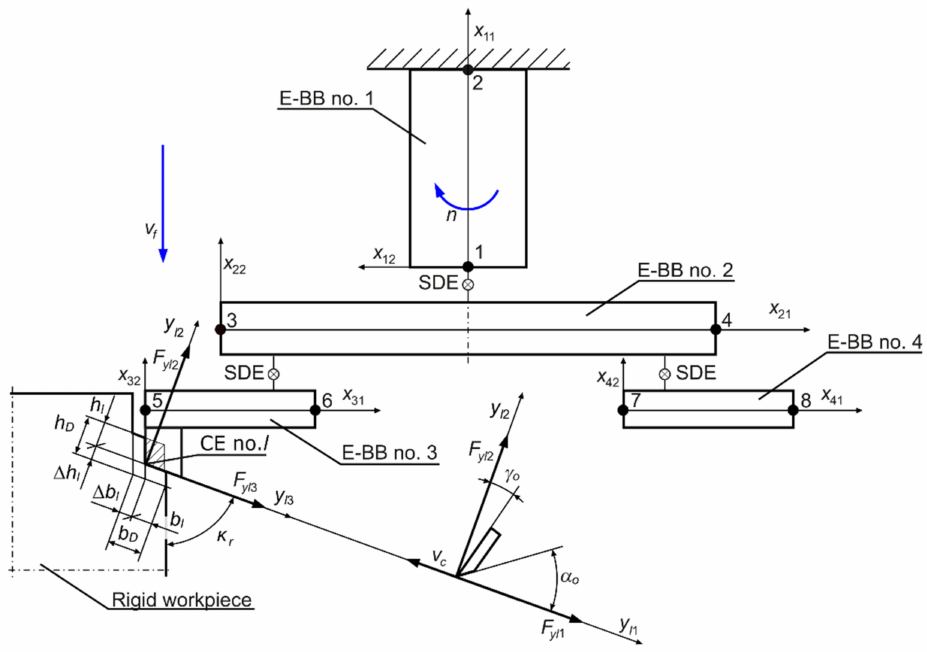
Figure 3. The computational model of boring process of the rigid workpiece in the FEM convention, including Euler–Bernoulli Bars (E-BB), Spring-Damping Elements (SDEs) and Coupling Element (CE) no. l